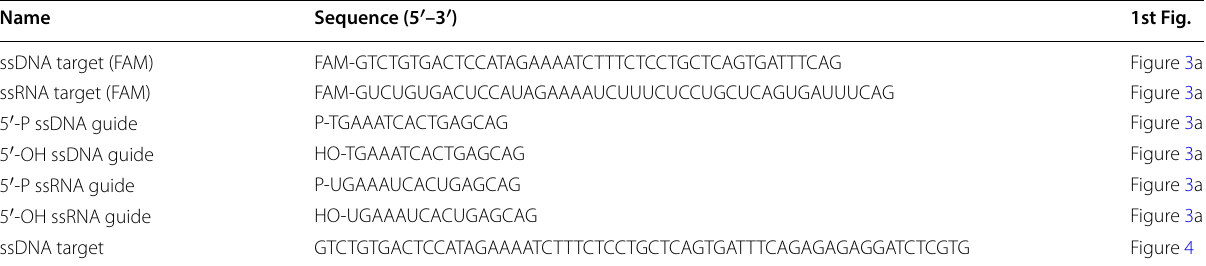
Table 2 Nucleic acids used in the